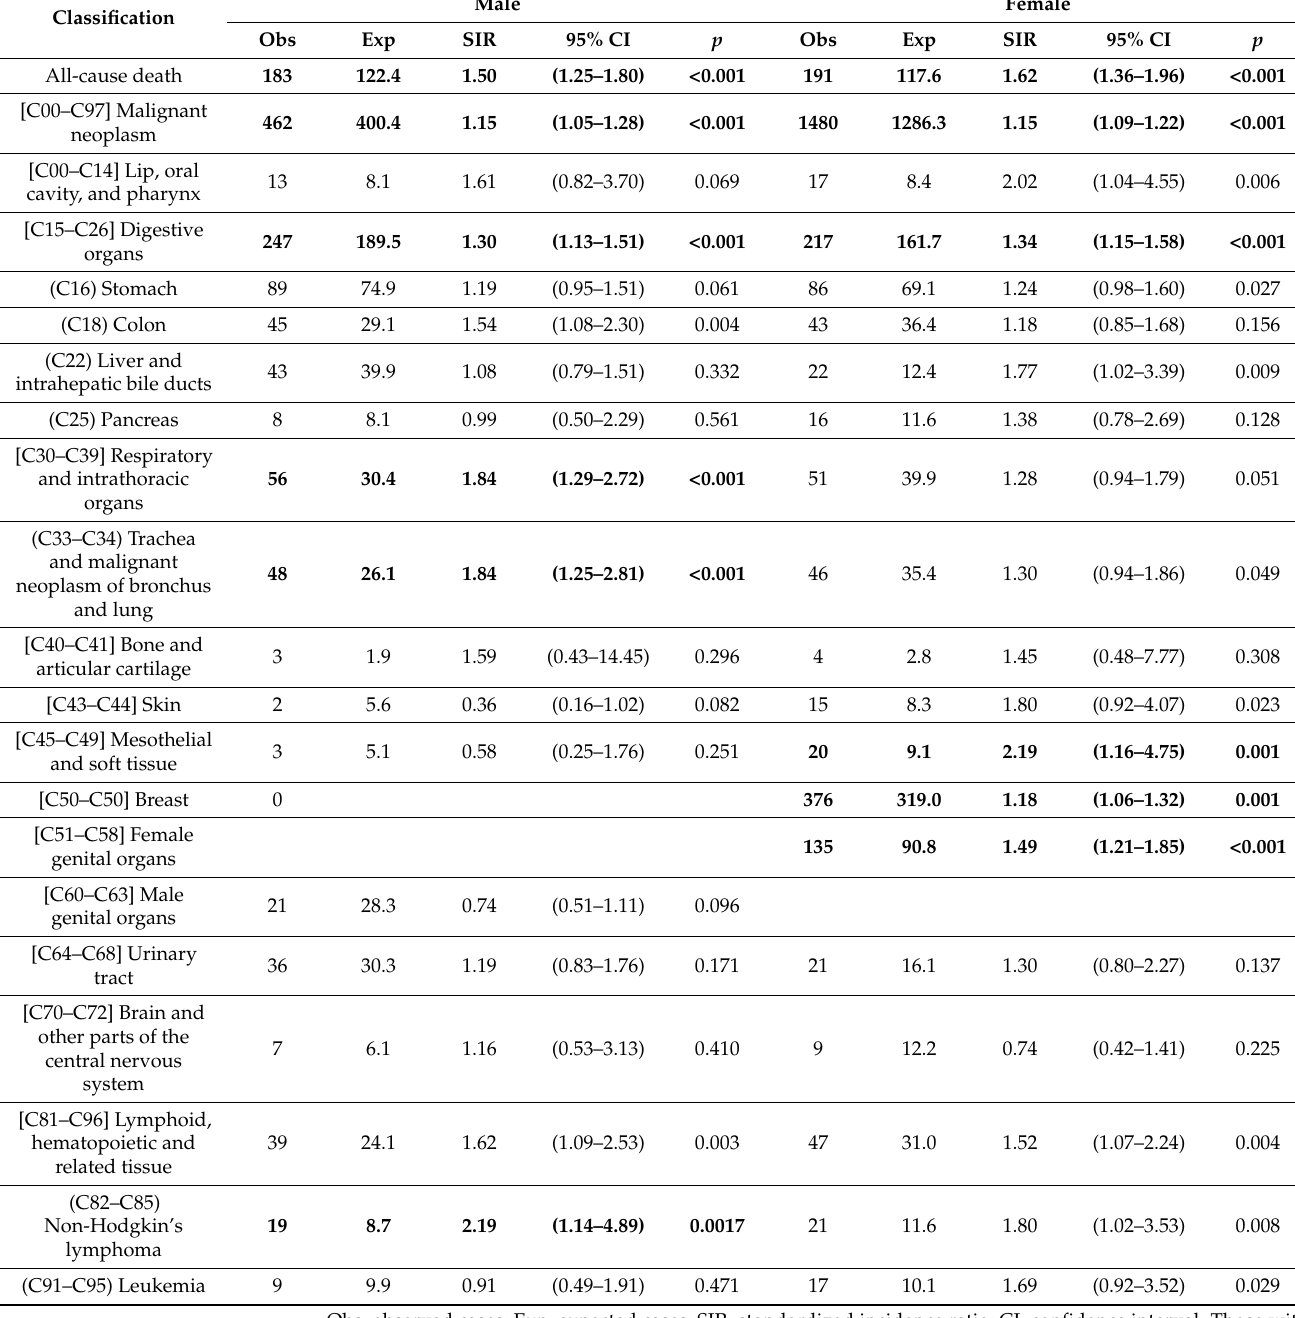
Table 3. The observed number of deaths, standardized incidence ratios, and 95% confidence intervals, with public officials as the reference